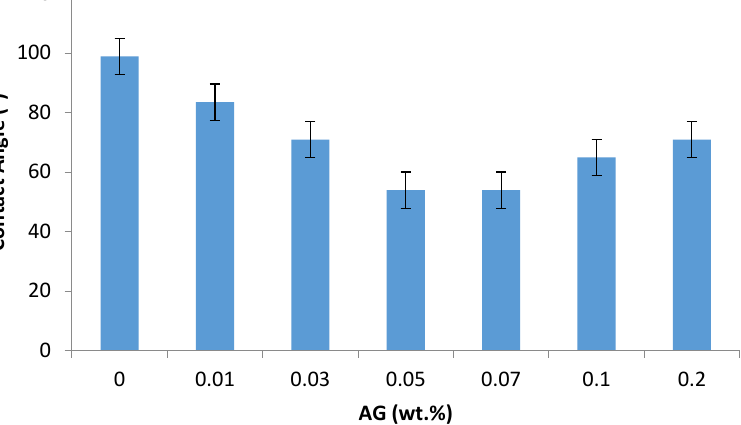
Figure 4. The contact angle of the prepared PA/AG membranes at different AG (wt.%) loadings in dope solutions.